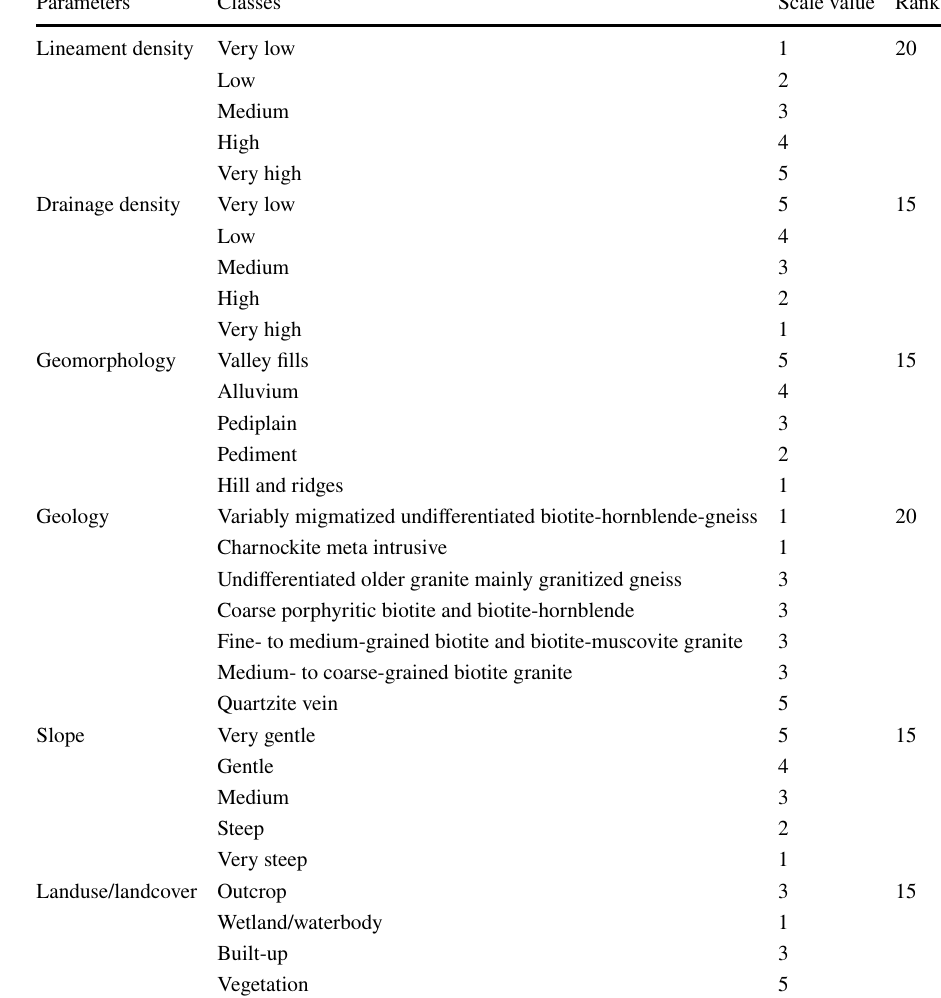
Table 3 Weighting combination for groundwater potential